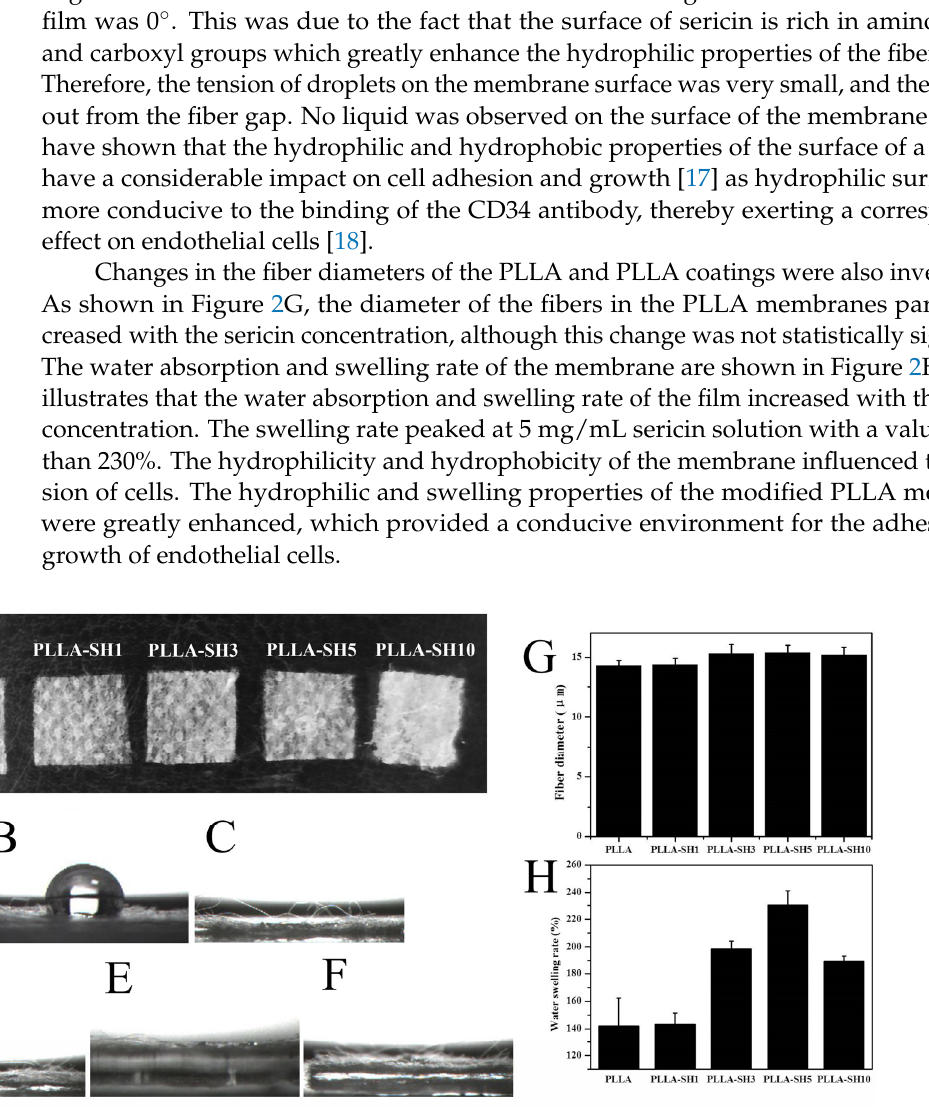
Figure 2. Characteristics of the sericin-modified fiber membranes: ( A ) photos of PLLA, PLLA- SH1, PLLA-SH3, PLLA-SH5, and PLLA-SH10; ( B – F ) contact angle analysis of PLLA, PLLA-SH1, PLLA-SH3, PLLA-SH5, and PLLA-SH10; ( G ) fiber diameter; and ( H ) swelling